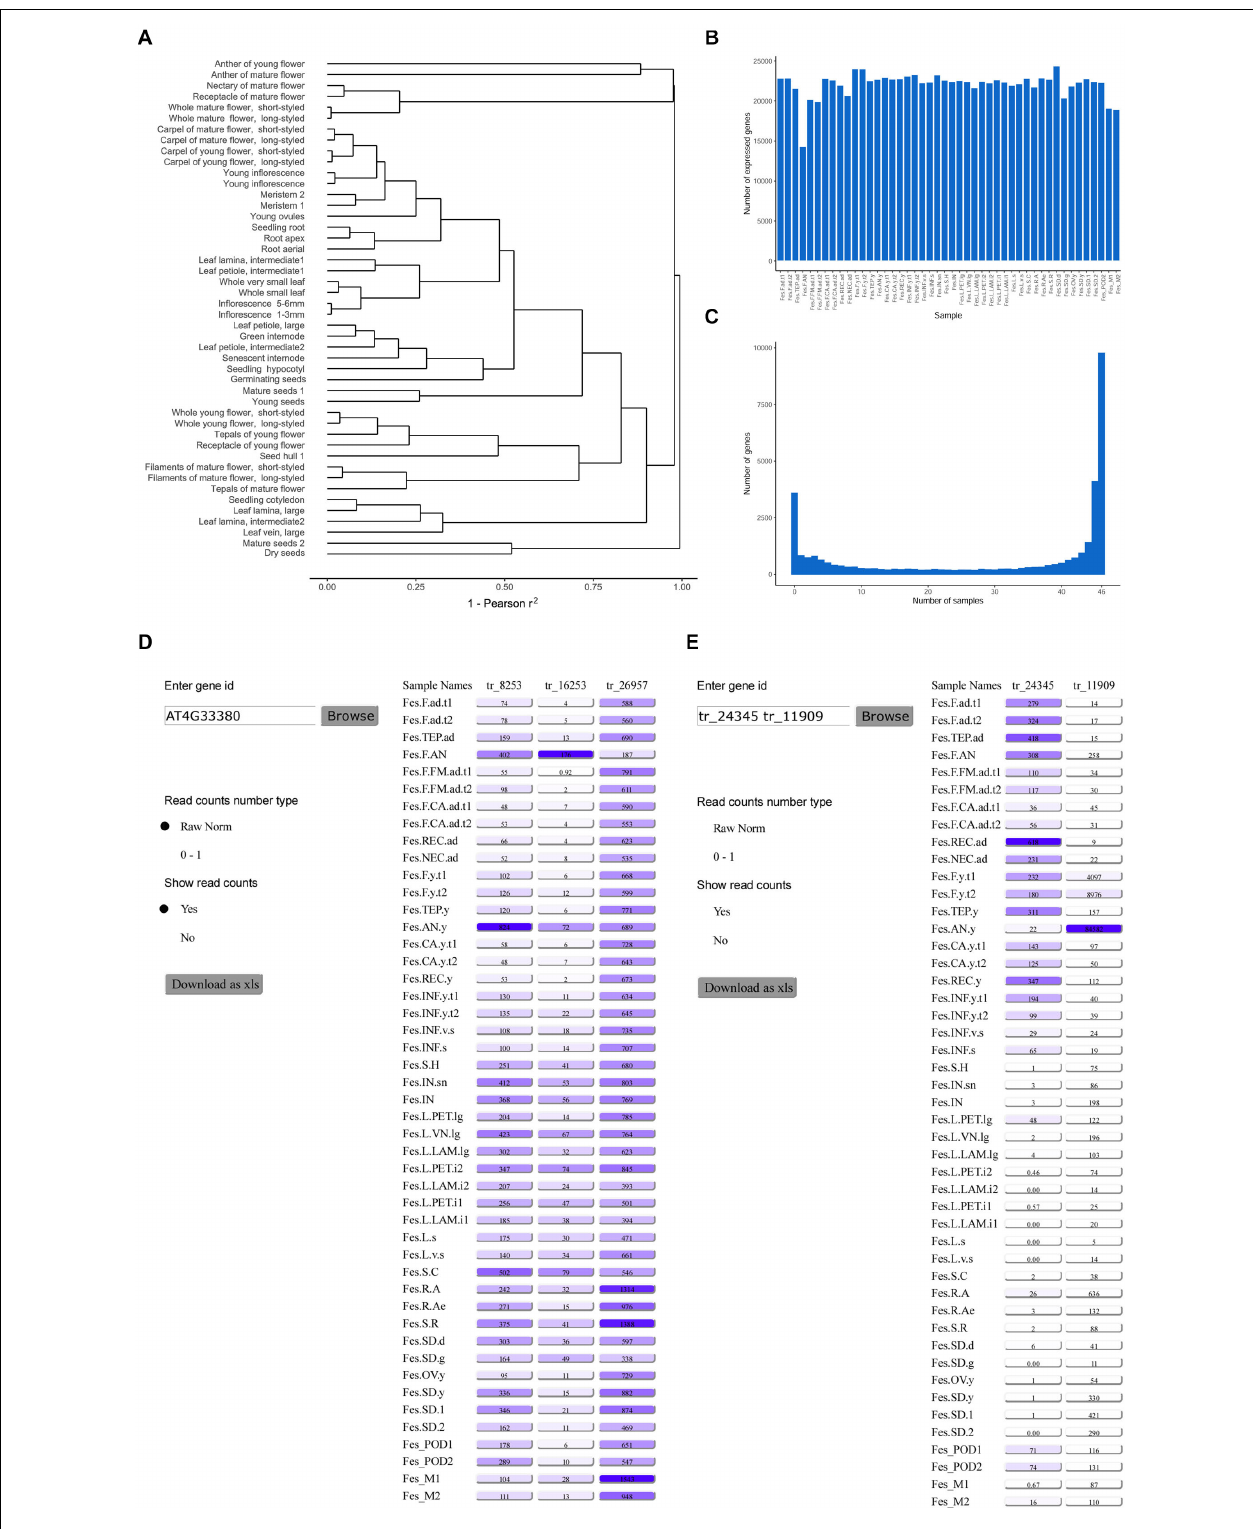
FIGURE 3 | (A) Clustering of the samples (the distance measure is 1 – square of Pearson correlation coefficient, the expression values for replicates are averaged). (B) The number of genes expressed in each sample. (C) The specificity of gene expression. (D) The interface of the FescTraVA database, showing an example of a search with an Arabidopsis TAIR gene ID. (E) An example of a search with a buckwheat gene ID. Numbers in boxes denote normalized read counts.